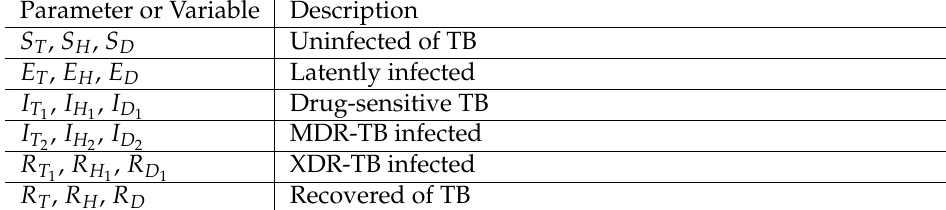
Table 1. Variables and parameters of